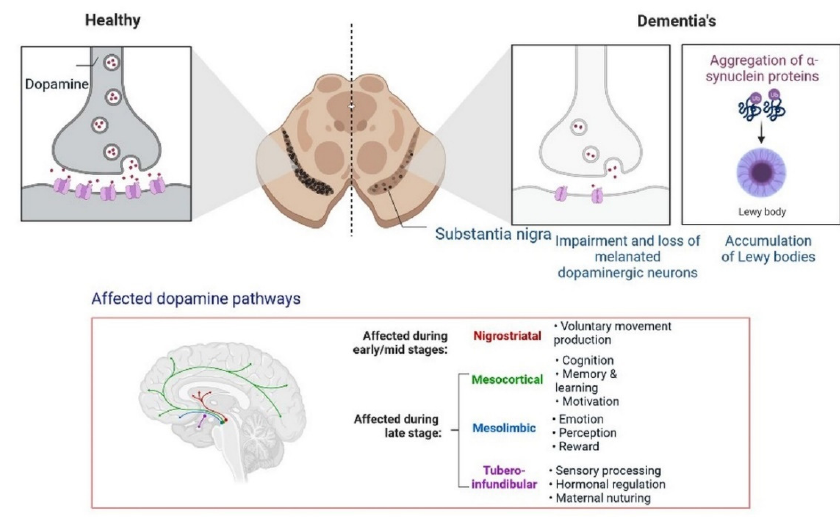
Figure 11. Progression of dementia due to dopamine dysregulation in substantia nigra.